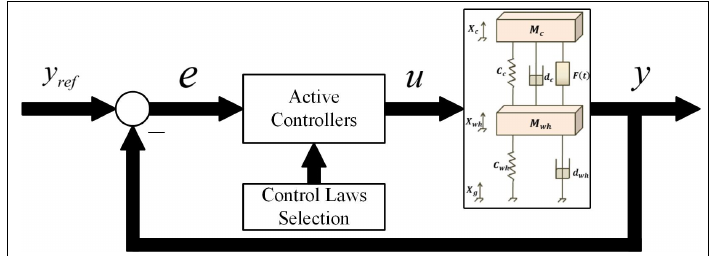
Figure 4. Schematic diagram of the closed-loop control system.